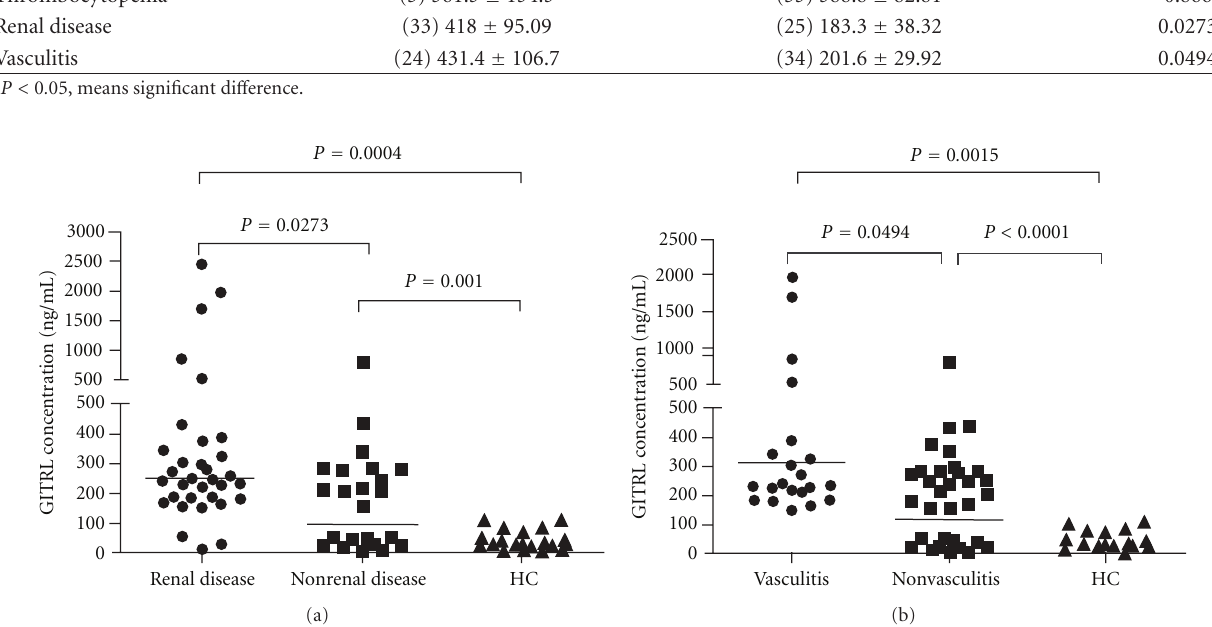
Figure 4: Elevated serum GITRL levels in SLE patients with organ damage. (a) Serum GITRL levels exhibited elevation in SLE patients with renal involvement ( n = 33) relative to patients without renal involvement ( n = 25) as well as HC. (b) Serum GITRL levels were higher in SLE patients with vasculitis ( n = 24) than patients in the absence of vasculitis ( n = 35) as well as HC. Each symbol represents an individual patient; horizontal lines indicate median values. GITRL: glucocorticoid-induced TNFR-related protein ligand; HC: healthy control; SLE: systemic lupus